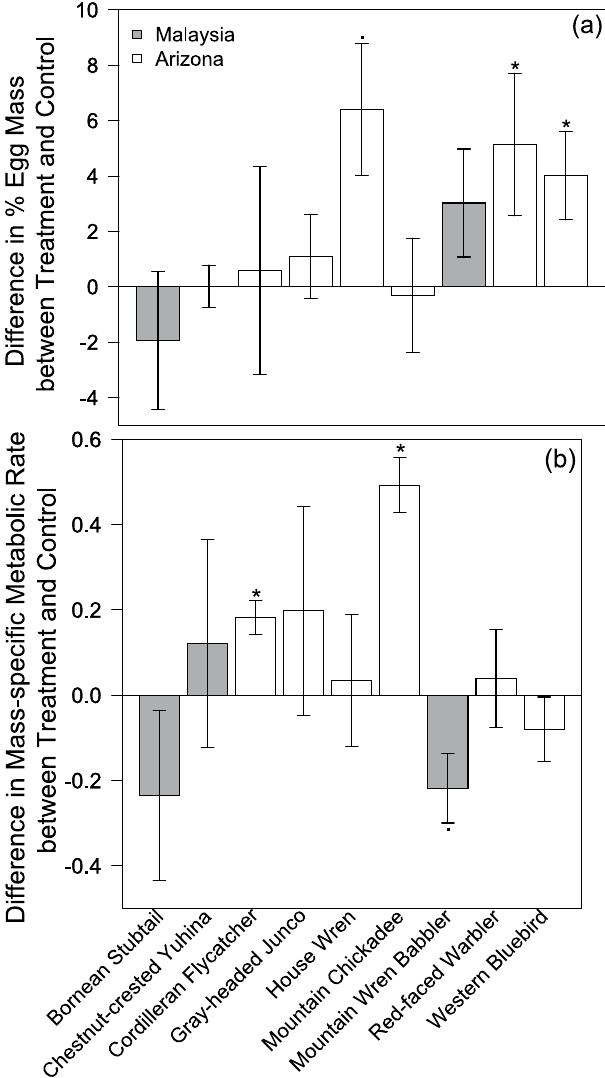
Figure 3. Mean differences between treatment and control ( ± 1 SE) in ( a ) % egg mass, and ( b ) mass-specific metabolic rate (mL O 2 h − 1 ) for nine bird species exposed to increased incubation temperature in a tropical (Malaysia) and north temperate (Arizona) site. Significant (p < 0.05) and marginally significant (p < 0.1) effects within species are denoted respectively as * and ●